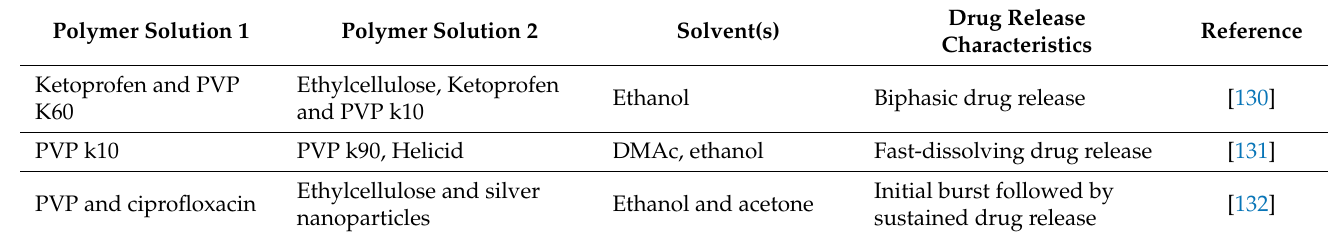
Table 5. Summarised characteristics some studies employing side-by-side electrospinning for drug delivery applications.